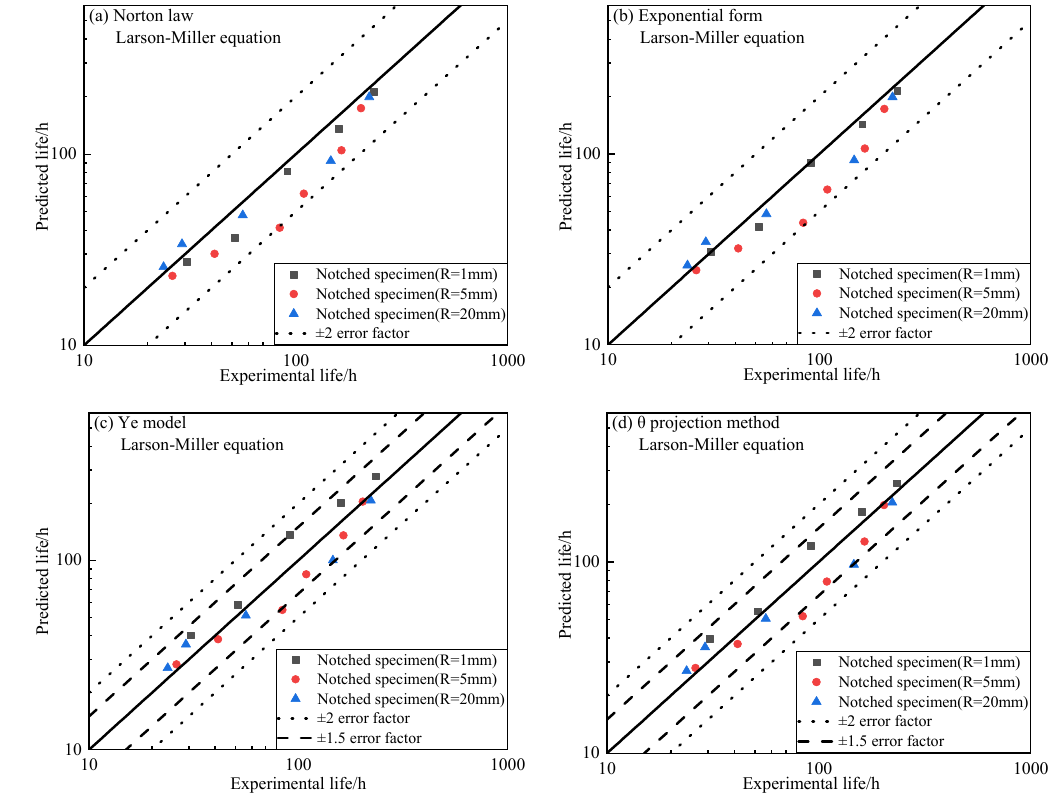
Figure 14. The prediction results are based on different constitutive models and Larson–Miller equa- tion: ( a ) Norton law; ( b ) Exponential form; ( c ) Ye model; ( d ) θ projection method.